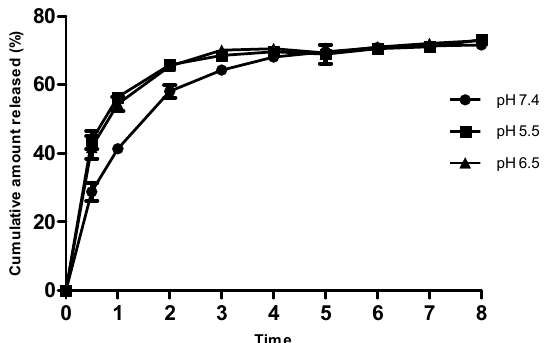
Figure 7. In vitro release profile of Ag-FSE CSNPs at pH 7.4, 5.5 and 6.5. Data are expressed in mean ± SD (n = 3).